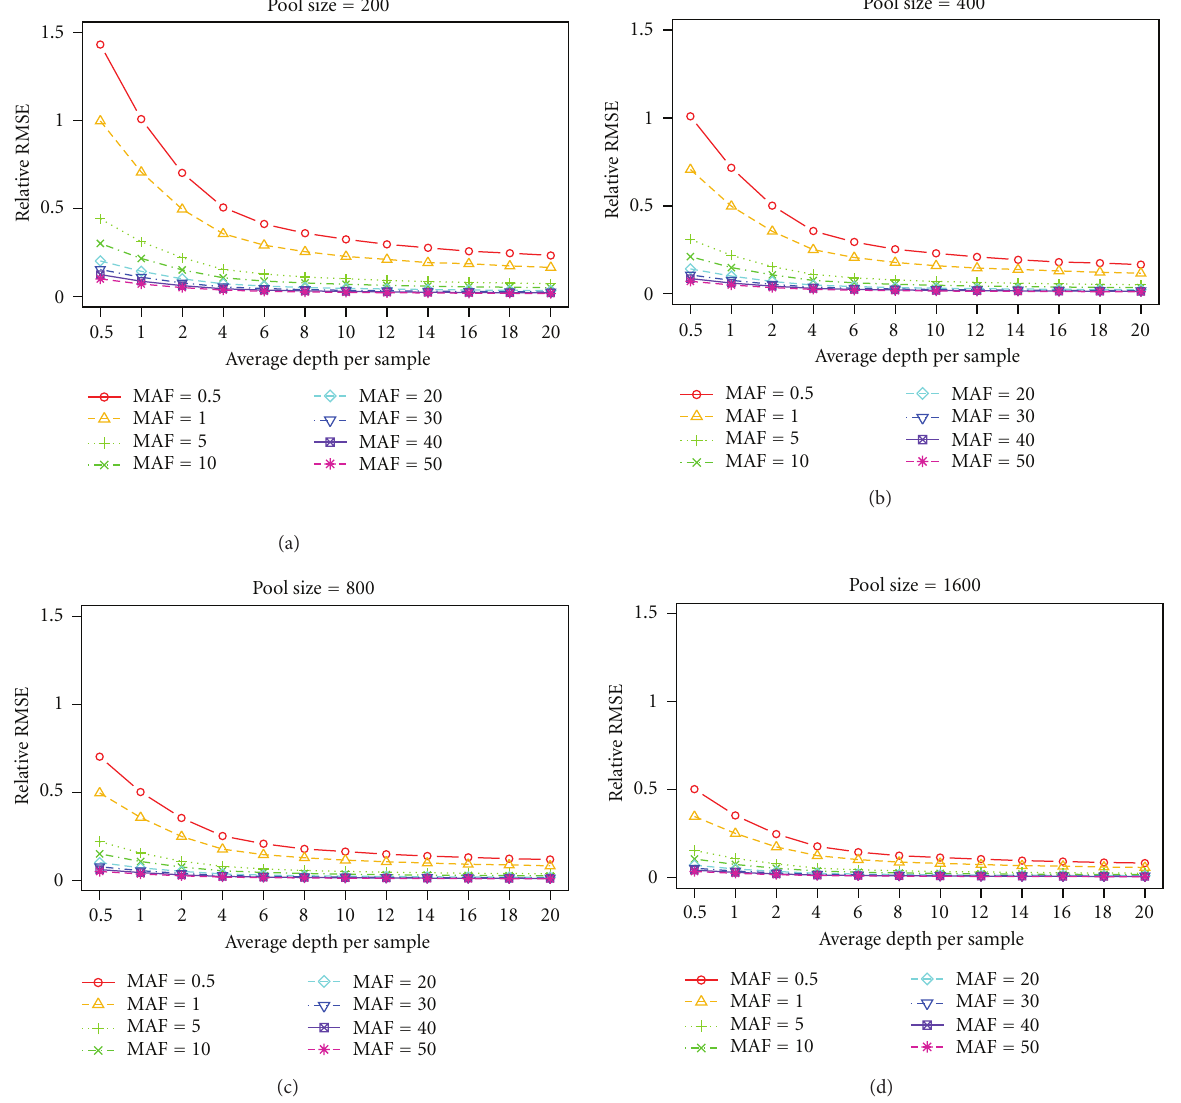
𝑁 = 200, 400, 800, and 1600 , and MAF = 0.5%, 1%, %5, 10%, 𝑠 20%, 30%, 40%, and 50%. Each allele frequency was simulated 10,000